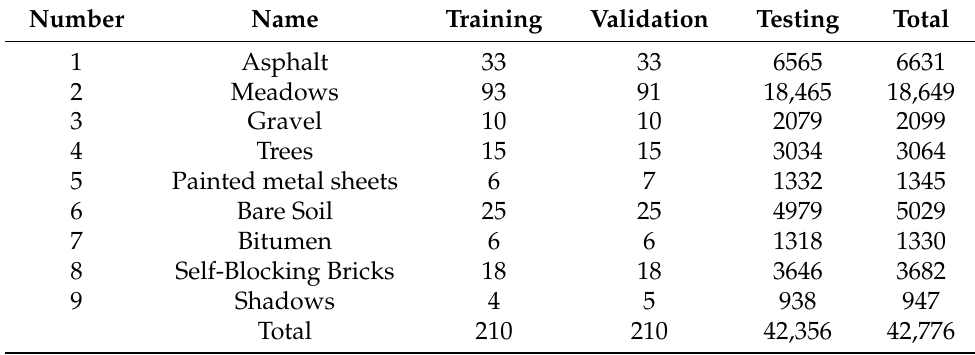
Table 3. Training, validation, and testing sample numbers in the University of